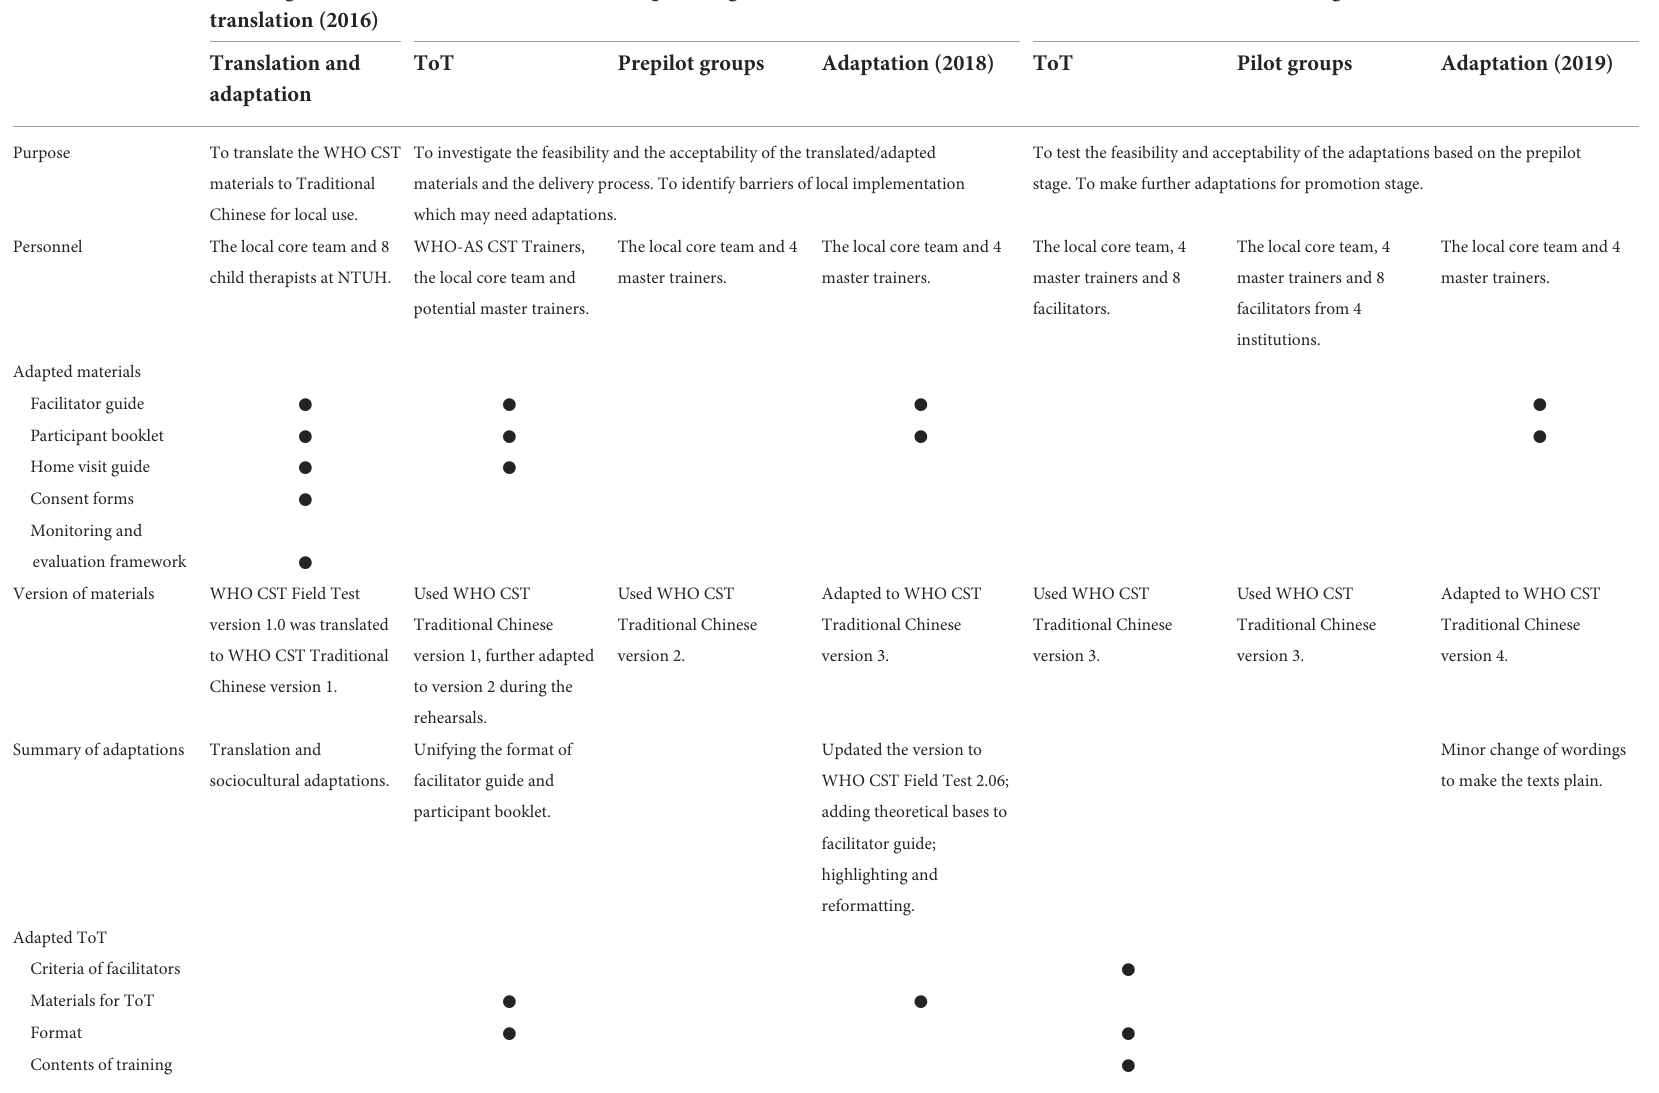
TABLE 1 Adaptation summary of